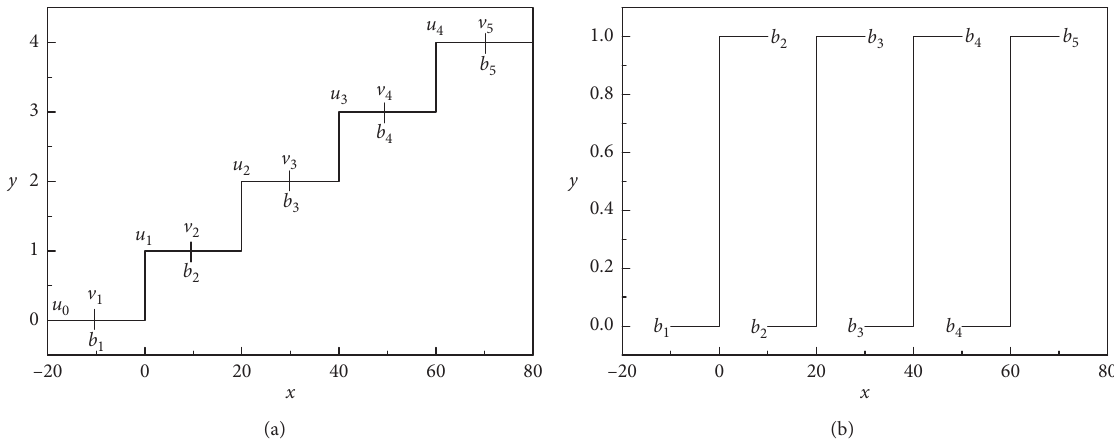
Figure 4: Schematic diagram of differential function interval division of the slip surface.